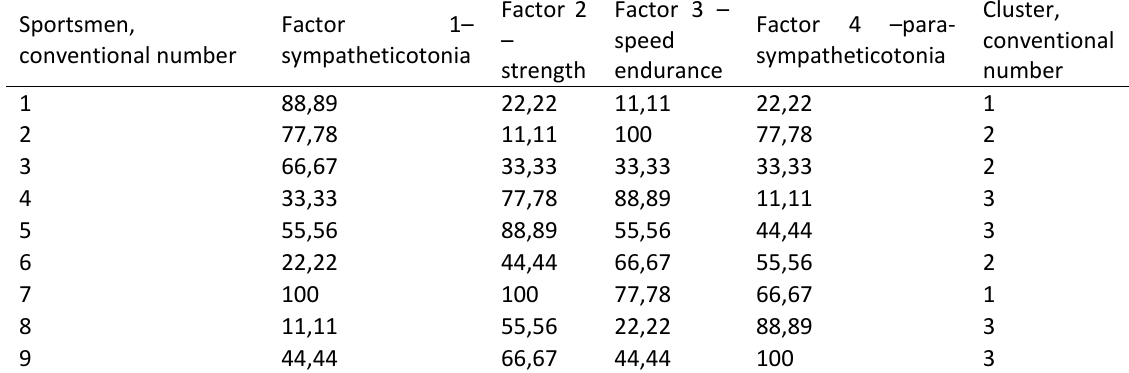
Table 2. Examples of individual factors’ expressiveness in structure of elite judo wrestlers’ fitness (%) and belonging to cluster in cluster analysis (conventional number)